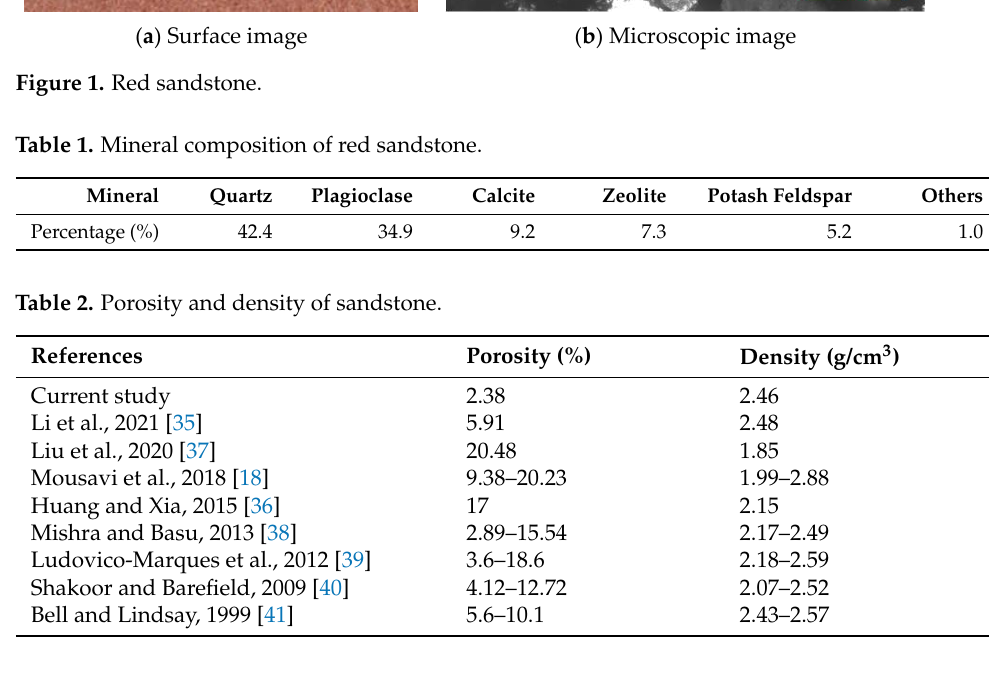
Table 3. Percentages of chemical